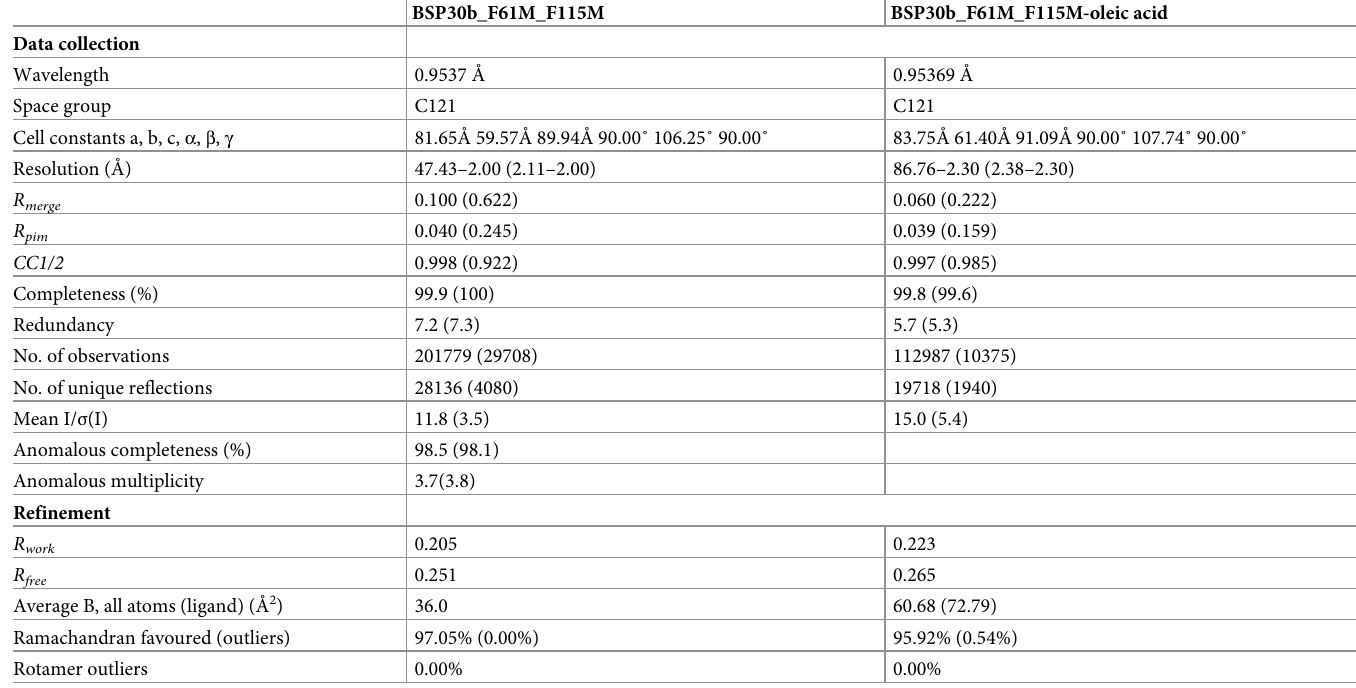
Table 1. Crystallographic data collection and refinement